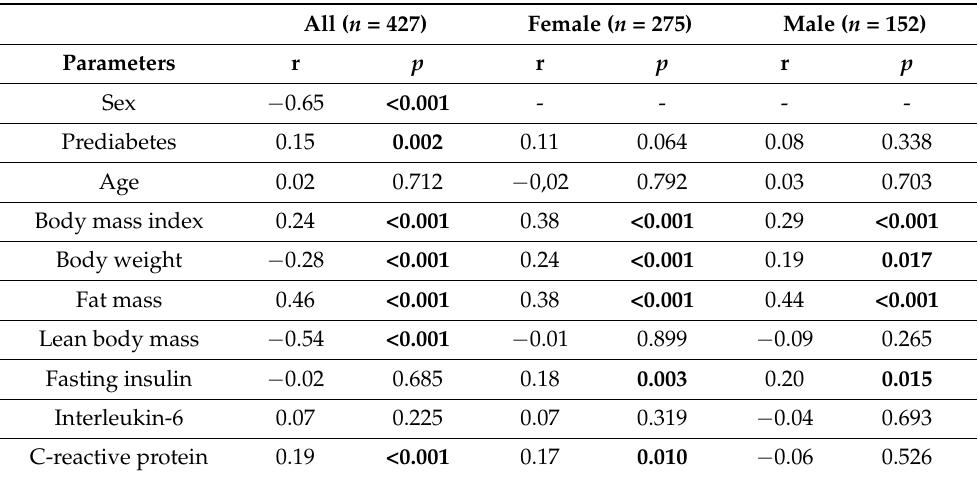
Table 2. Associations between baseline leptin and baseline